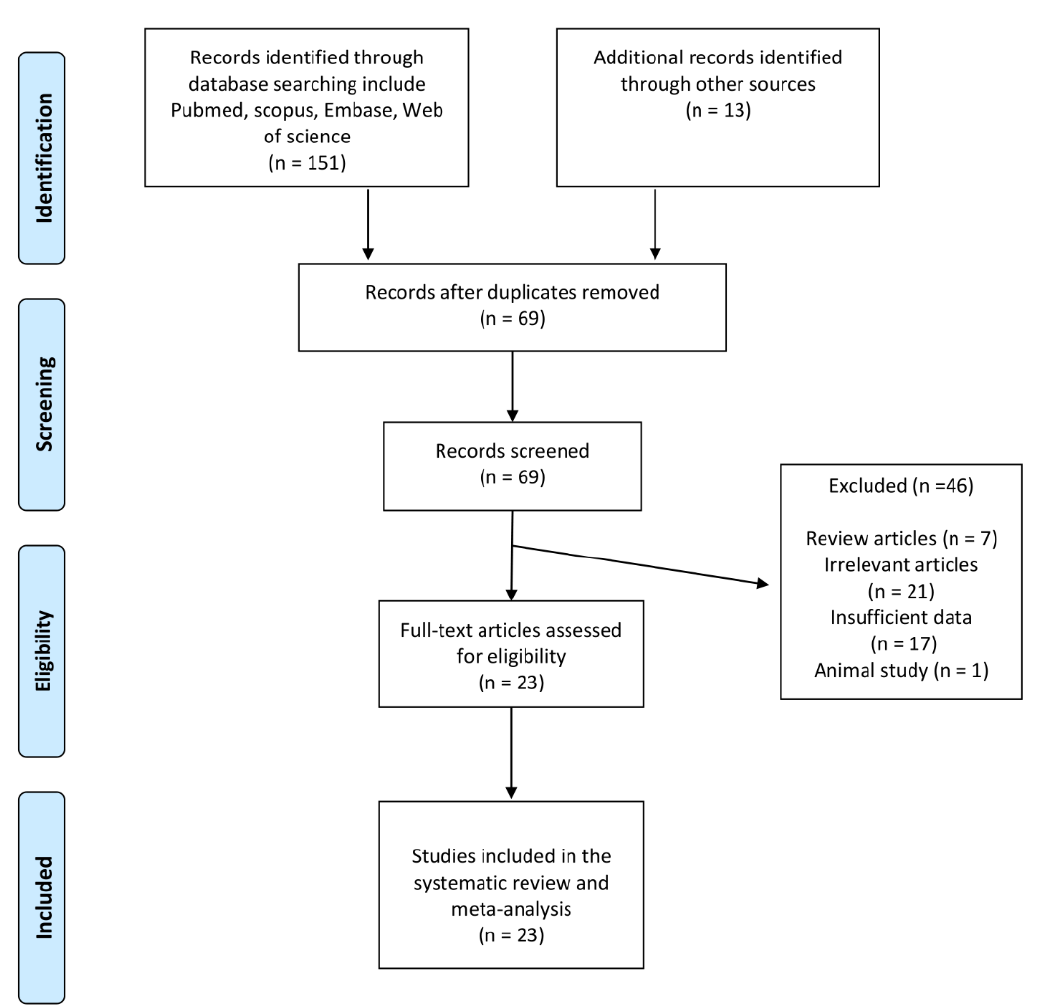
Figure 1. Flow chart of identified and included publications into meta-analysis. Table 2. Characteristics of studies measuring FMD.